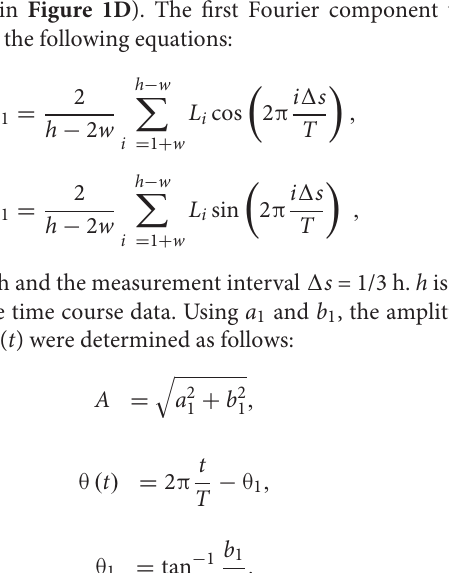
w is the half window size of the moving average.